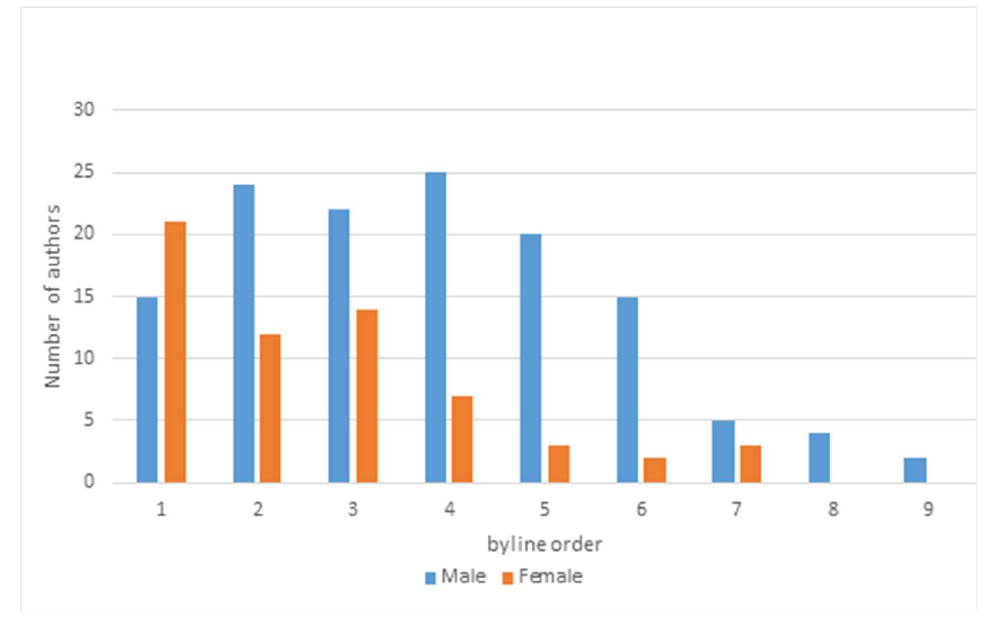
Figure 6. Number of male and female authors by byline